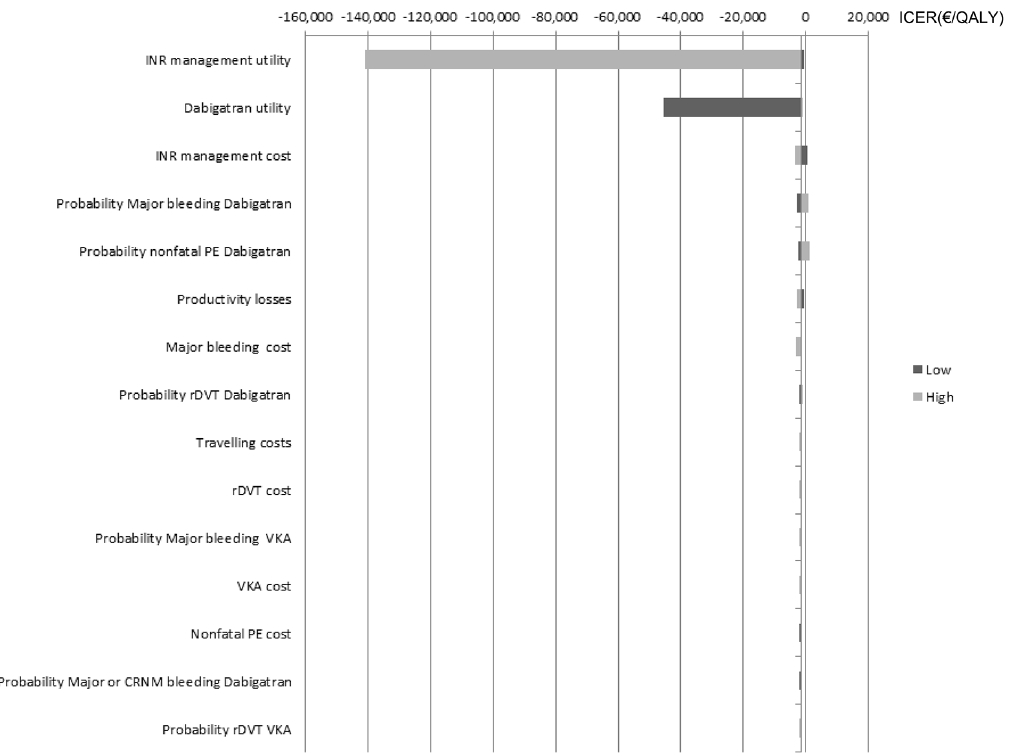
Fig 2. Tornado diagram illustrating the impact on the ICER from sensitivity analyses for dabigatran vs. vitamin-K antagonists. Light grey bars denote influence of the high value of the 95% confidence interval range and dark grey bars denote influence of the low value for parameters investigated. The solid vertical line represents the base case incremental costs per QALY for dabigatran compared to VKA. Horizontal bars indicate the range of incremental costs per QALY obtained by setting each variable to the values shown while holding all other values constant. ICER, incremental cost-effectiveness ratio; INR, international normalized ratio; PE, pulmonary embolism; rDVT, recurrent deep vein thrombosis; VKA, vitamin K antagonist; CRNM, clinically relevant non-major.